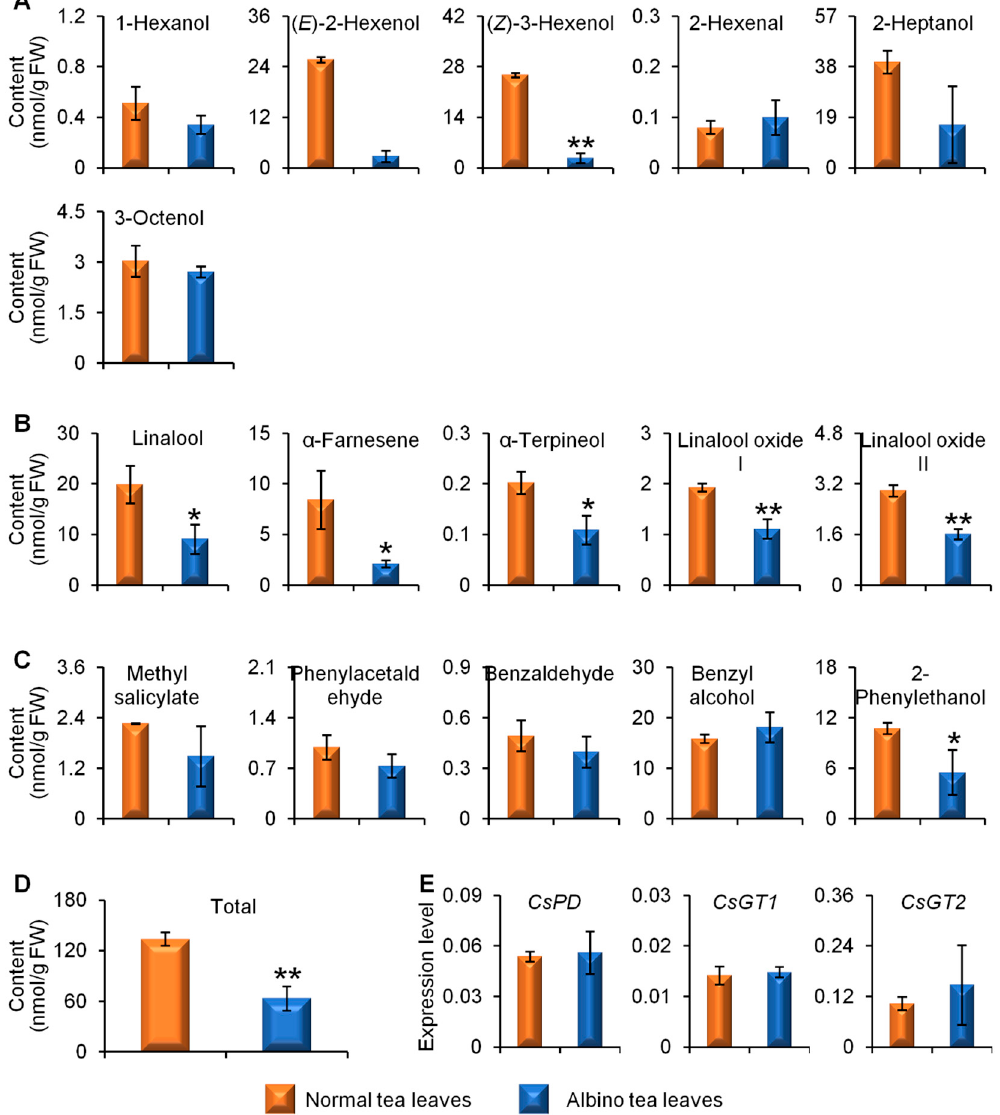
Figure 4. Differential accumulation of glycosidically bound aromas (GBVs) ( A – D ) and expression levels of genes involved in aroma compounds synthesis from glycosidic hydrolysis ( E ) in normal green and albino-induced yellow tea ( Camellia sinensis ) leaves (cv. Yinghong No. 9) collected in April. The content of GBVs were calculated based on the enzyme reaction products under β -primeverosidase and β -glucosidase catalyzation. ( A ) aroma fatty acid derivatives; ( B ) aroma terpenes; ( C ) aroma phenylpropanoids/benzenoids; ( D ) total content of aroma compounds shown in ( A – C ). The identification and quantitative analysis of the aroma compounds is summarized in Table S1 (Supplementary Information). FW, fresh weight. ( E ) PD , β -primeverosidase ; GT , glycosyltransferase . All data are expressed as mean ± S.D. ( n = 3). Significant differences between normal and albino tea leaves are indicated (* p ≤ 0.05, and ** p ≤ 0.01).